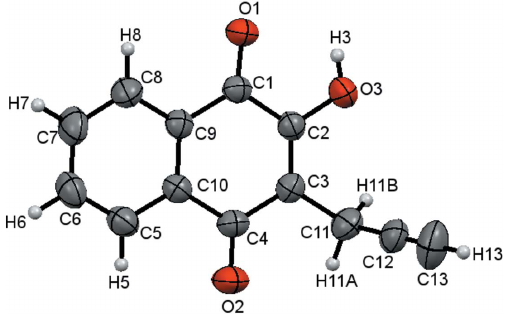
Figure 1 The molecular structure of the title compound 3 . Displacement ellipsoids are drawn at the 50% probability